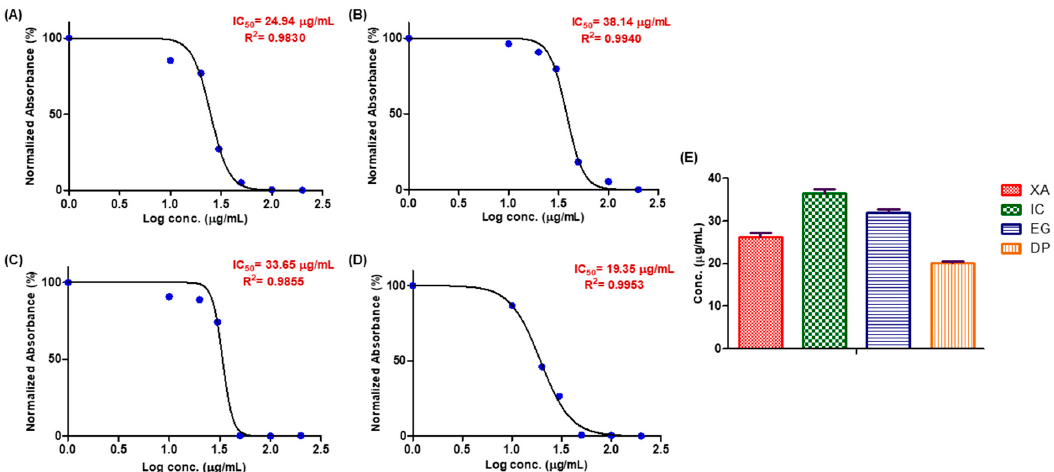
Figure 1. SRB assay on HeLa cells to evaluate the effect of the four plant extracts: ( A) Xylopia aethiopica (XA), ( B ) Imperata cylindrica (IC), ( C ) Echinops giganteus (EG) and ( D ) Dorstenia psilurus (DP) on the cell growth after 48 h (X-axis: log concentrations of extracts from 1 to 200 (µg/mL) and Y-axis: the percentage of normalized absorbance). While ( E ): The comparison of average IC 50 of the four plant extracts over 48 h (Y- axis: concentration in (µg/mL). Values are mean ± SD of three independent experiments.